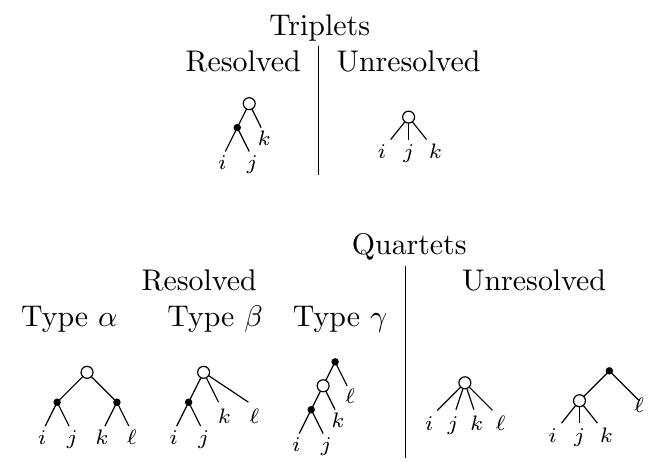
Figure 12. The anchors (white nodes) of resolved and unresolved triplets and quartets. Edges in the figures represents paths in the